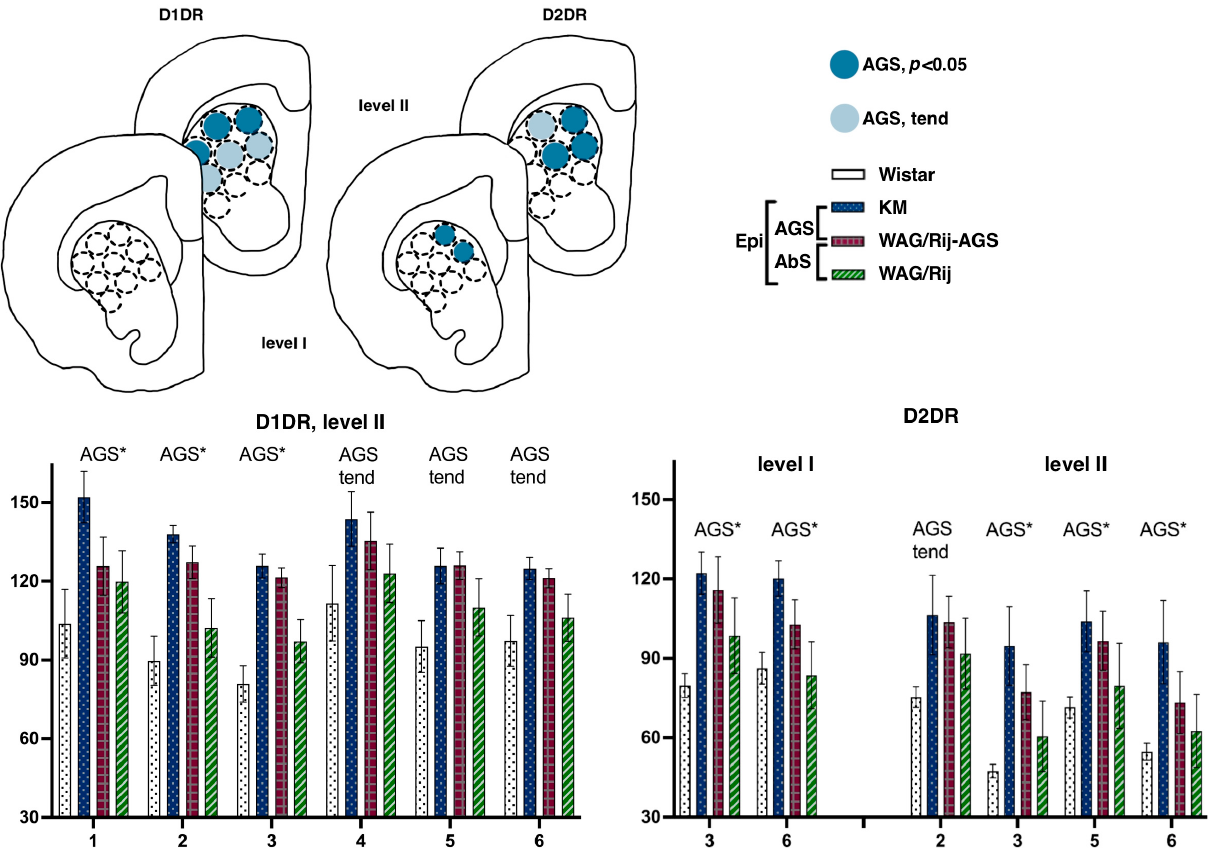
Figure 4. Comparisons of the dorsal striatum binding densities to D1DRand D2DR. The values are given as mean ± SEM, in pmol/g of tissue. For anatomical levels and abbreviations, see Figure 3. Differences are denoted by ‘*’ for p ≤ 0.05 and ‘tend’ sign for tendency (0.05 < p < 0.10). Effects of audiogenic epilepsy are marked by the “AGS” sign.